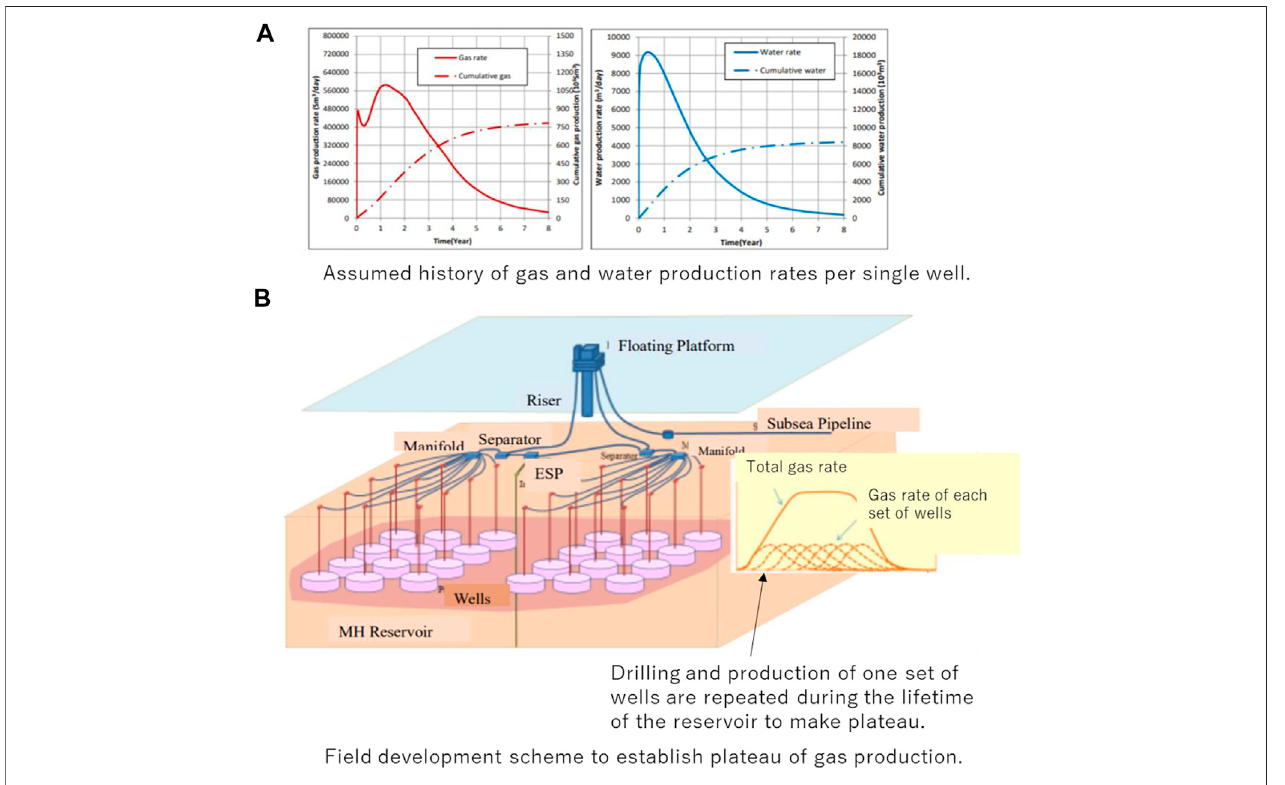
FIGURE 7 | (A) Example of gas and water production behavior calculated by the numerical simulator MH21-Hydres and an assumed reservoir model, and (B) schematicofthewelldrillingplantomaketheplateau ofthetotalproduction rate.(Modi fi edfromResearchConsortium forMethaneHydrate ResourcesinJapan,2019).